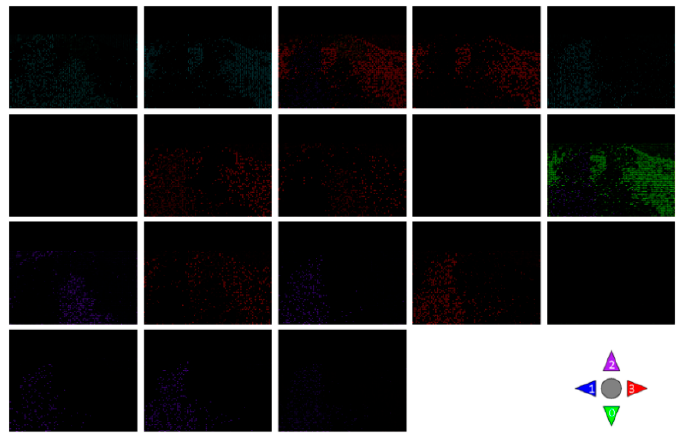
Figure 9. Eighteen latent motion topics discovered by RTM-GS.